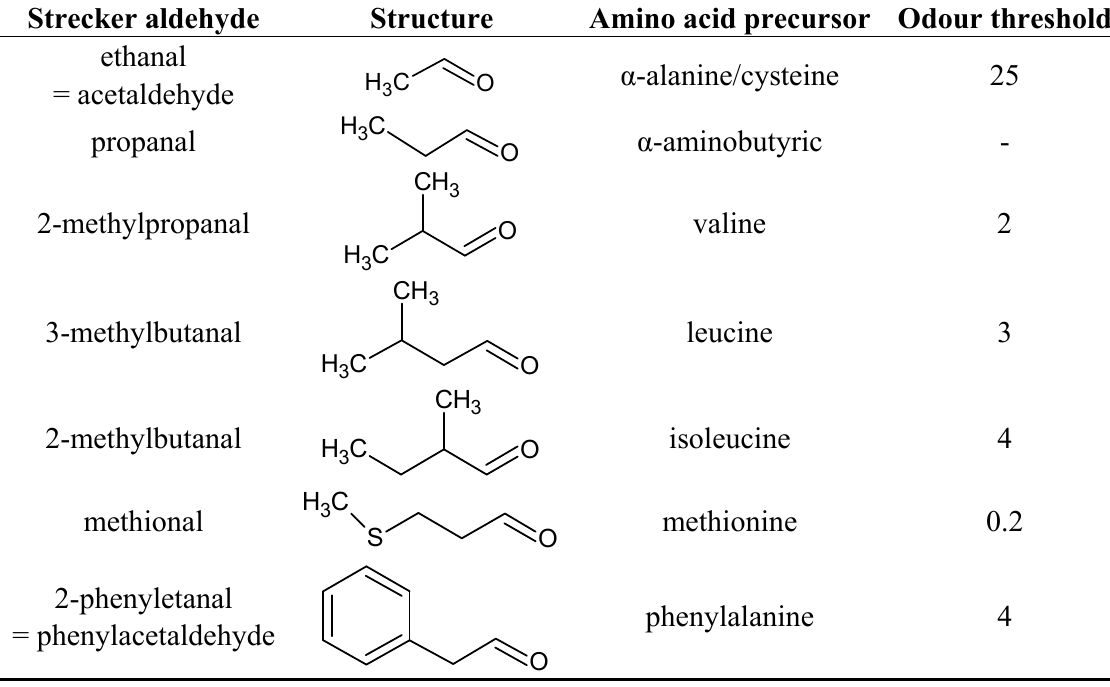
Table 4. Strecker aldehydes detected by GC-O in cooked beef extractions a , amino acid precursor, and odour threshold b